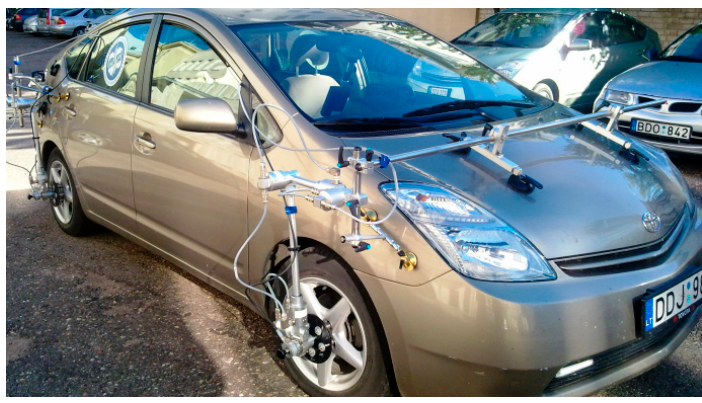
Figure 4. Test vehicle.